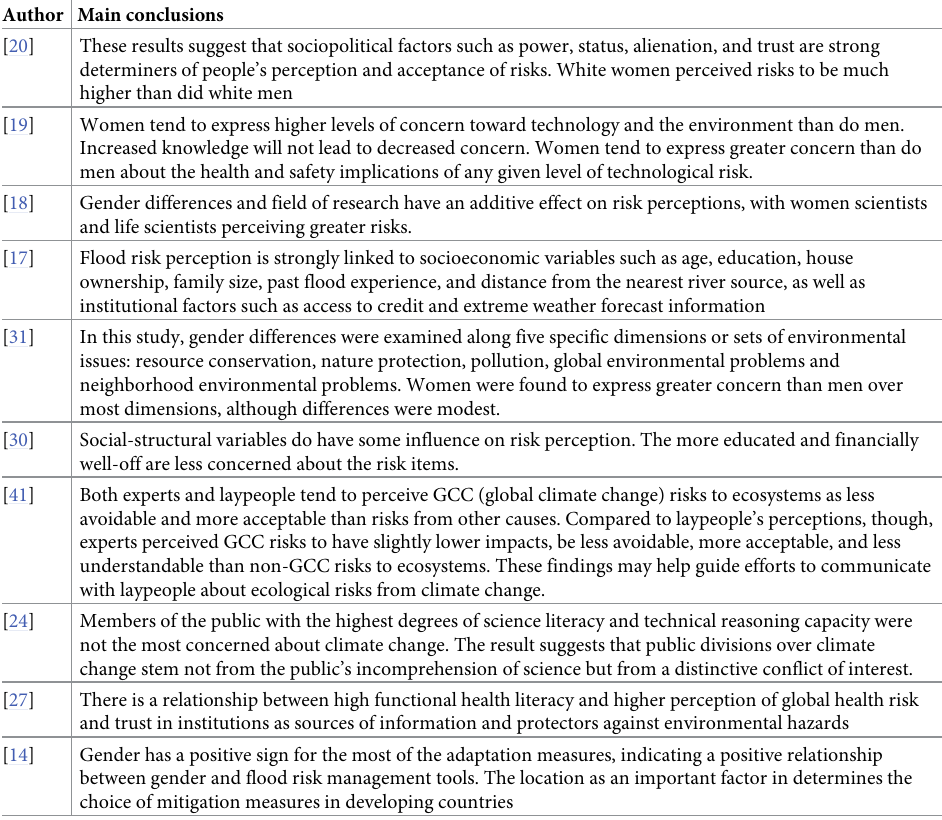
Table 5. Included studies for a qualitative